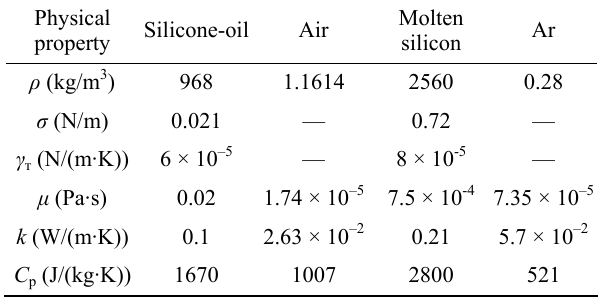
Table 1 Physical properties of fluids (silicone-oil, air at 25 ° C, molten silicone, Ar at 1,427 °